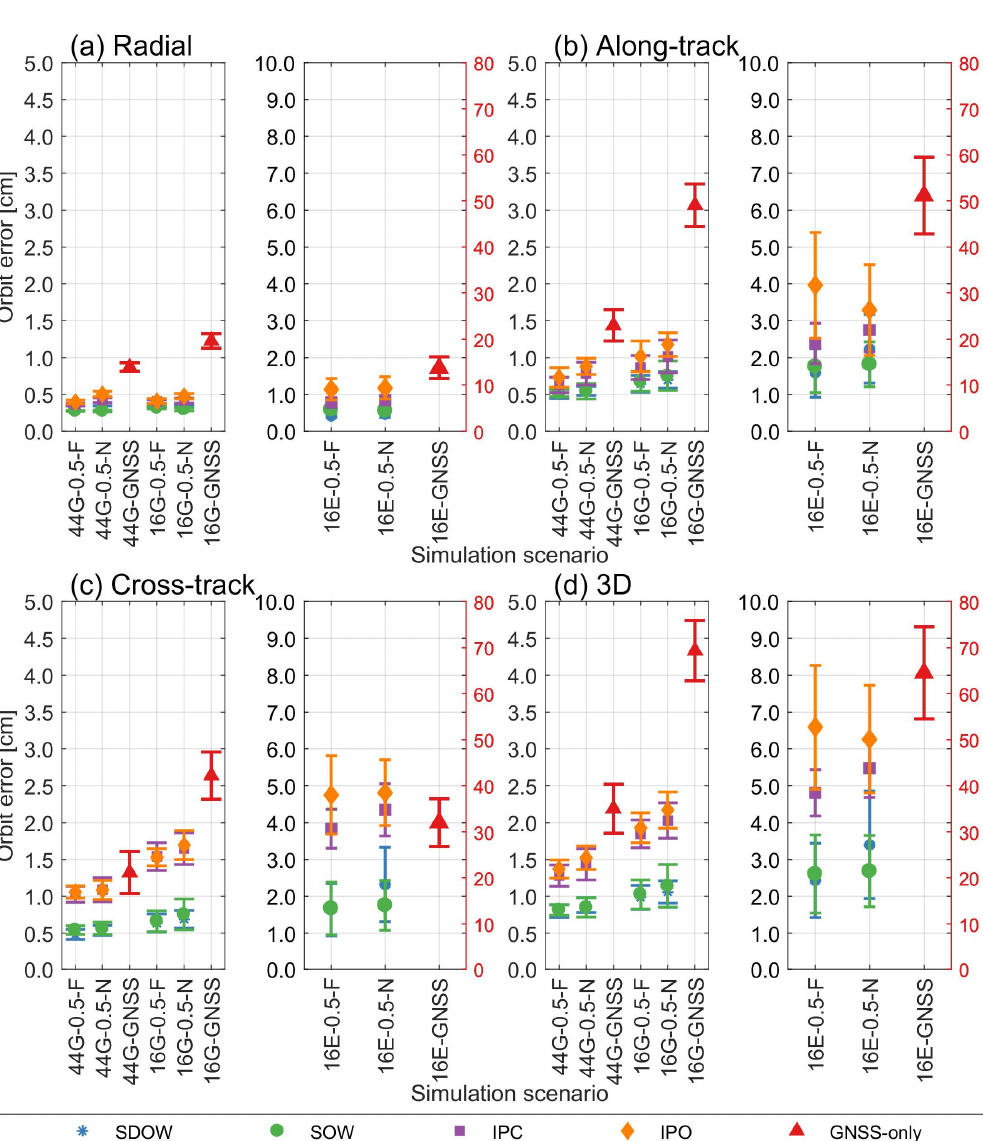
Figure A2. Impact of ground station set on orbit estimation mean RMS errors for ( a ) radial, ( b ) along-track, ( c ) cross-track components, and ( d ) the total 3D RMS value. Description of simulation scenario names are given in Table 7. Please note the different y-axis scale for the regional station set and the GNSS-only solution. The results in cm for GNSS-only are on the vertical axis on the right marked in red.